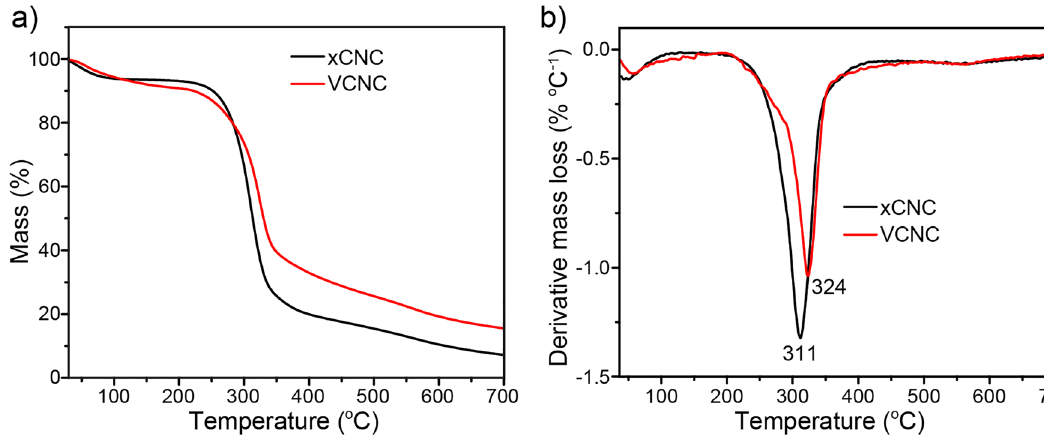
Figure 9. TGA results of XCNC and VCNC; ( a ) TG curves, and ( b ) DTG curves.